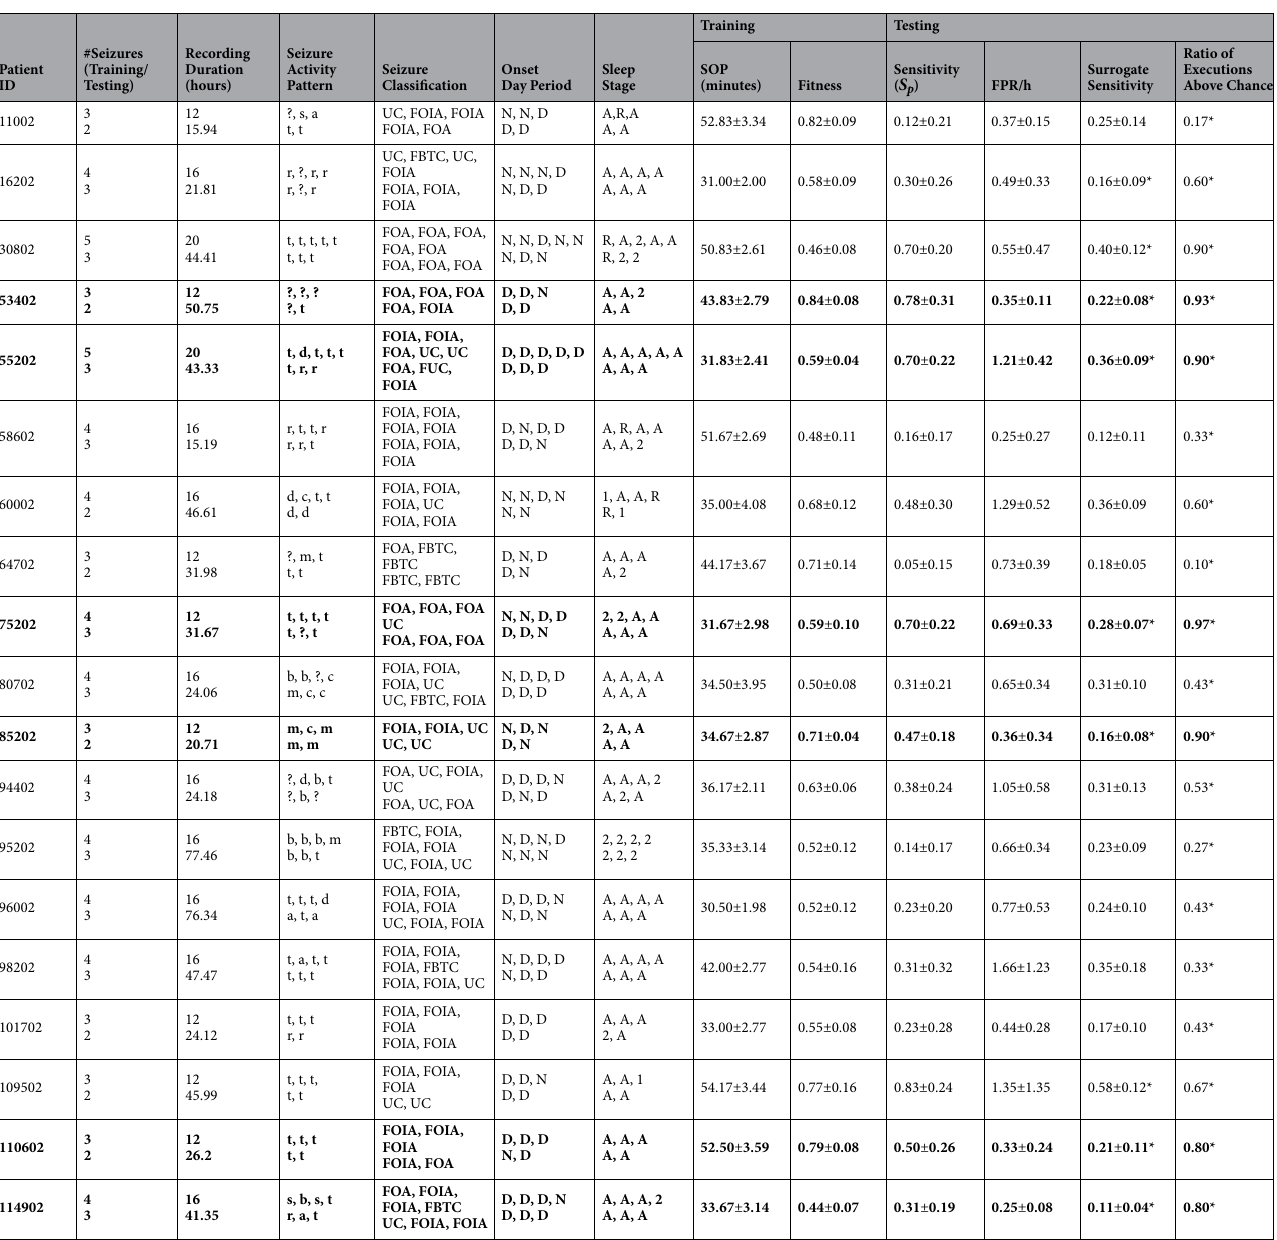
Table 1. Patient information and results for the EA 30 executions. For each seizure, it is presented its EPILEPSIAE ID, the number of seizures used for training and testing and their recording duration, the annotated activity pattern (unclear (?), rhythmic sharp waves (s), rhythmic alpha waves (a), rhythmic delta waves (d), rhythmic theta waves (t), rhythmic beta waves (b), repetitive spiking (r), cessation of inter-ictal activity (c), amplitude depression (m)), seizure classification (unclassified (UC), Focal Onset Aware (FOA), Focal Onset Impaired Awareness (FOIA), Focal to Bilateral Tonic-Clonic (FBTC)), and period of the day at onset (day, between 7 am and 10 pm (D), and night, between 10 pm and 7 am (N)). Training and testing results are also presented, where the last two columns concern the two performance statistical validations (* stands for statistical